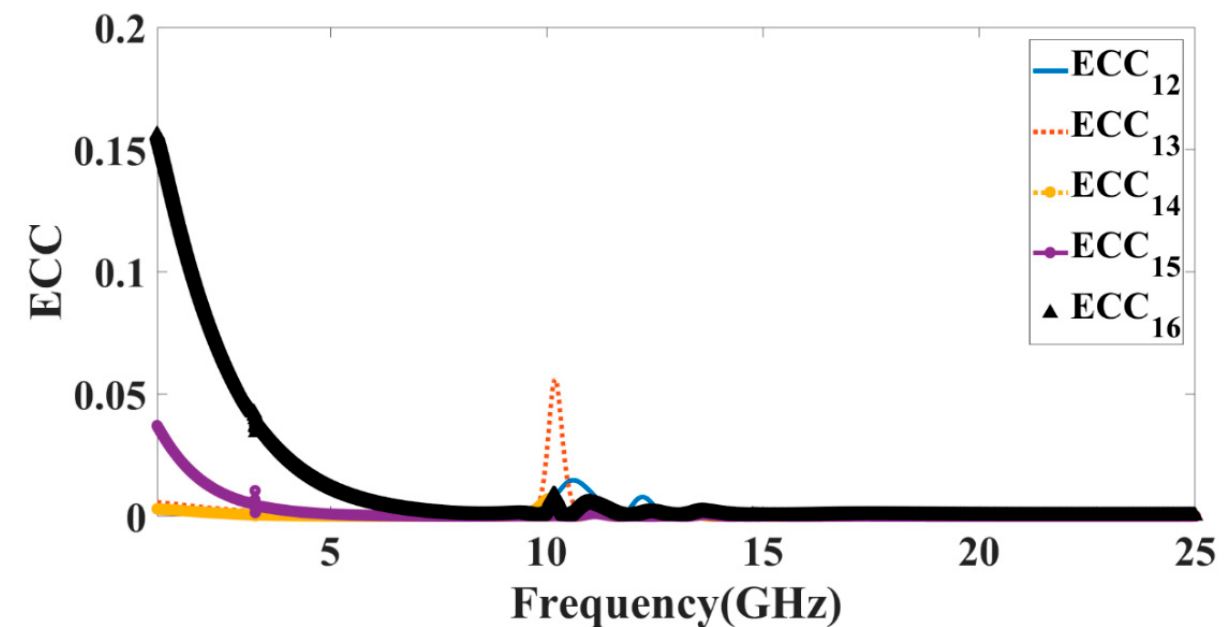
Figure 12. Calculated values of the ECC for antenna Design 5.